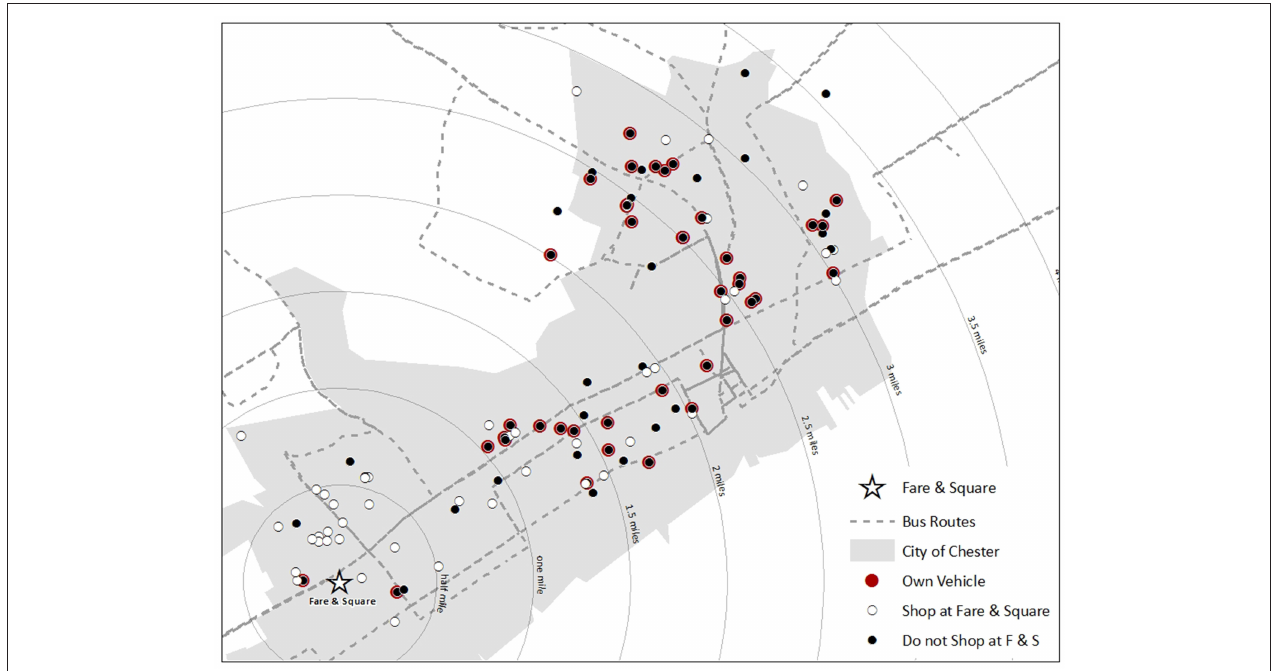
FIGURE 1 | Map of study participants and car